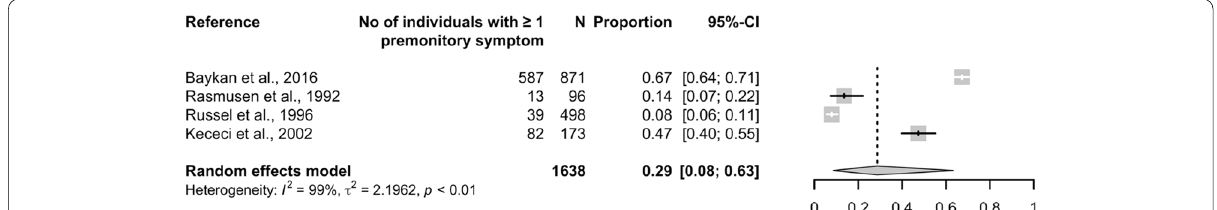
Fig. 2 Prevalence of one or more premonitory symptoms in individuals with migraine in population-based studies